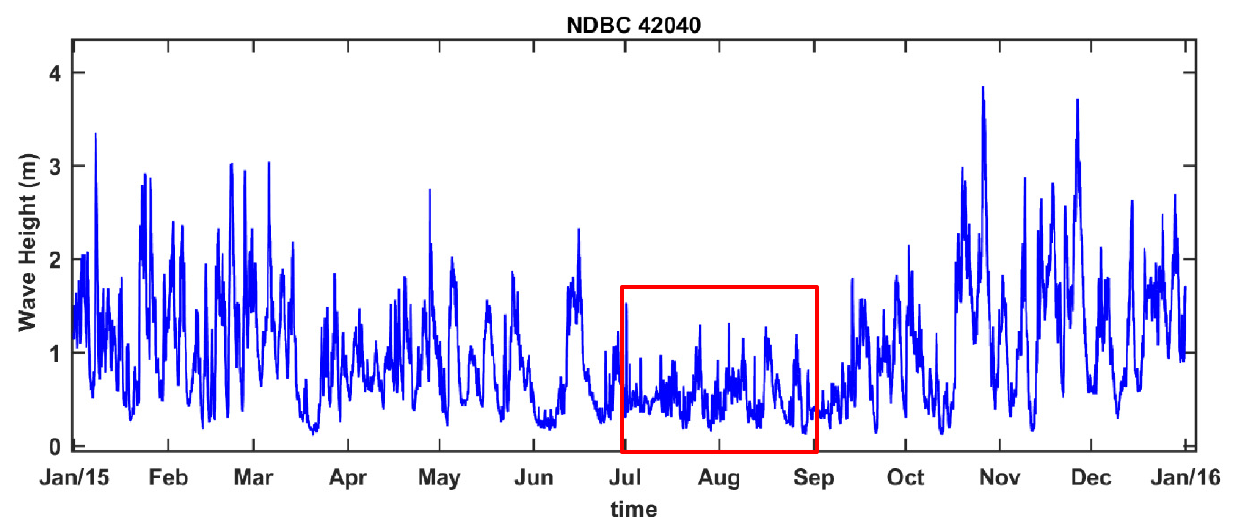
Figure 2. Significant decline in wave height in July and August 2015 (specified by the red box) based on measurements at station NDBC 42040.